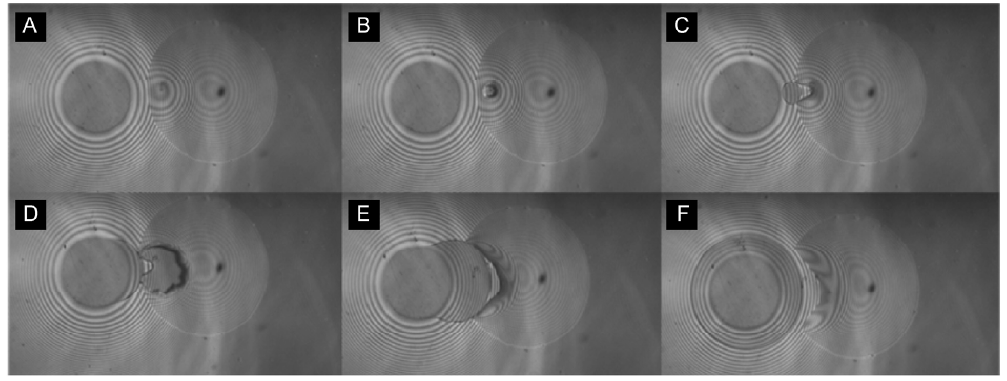
Fig. 8 Droplet spreading of silicone 201-1000, w = 30 N, D ini = 680 μ m.